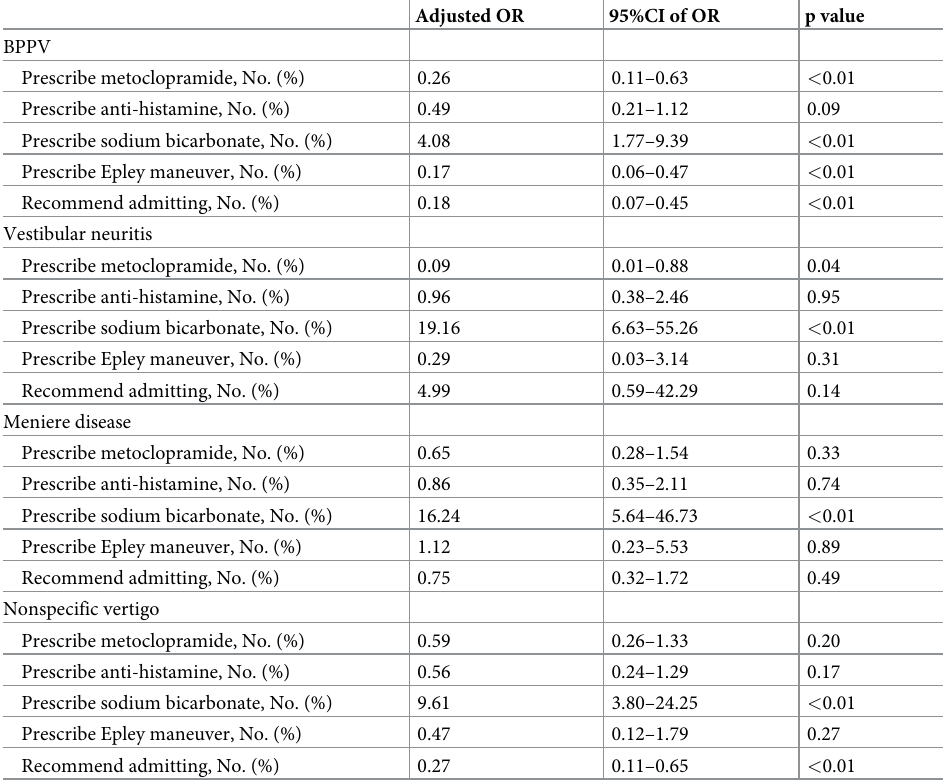
Table 5. The odds ratio and for physician’s willingness to perform each treatment and disposition among otolar- yngologists compared to non-otolaryngologists by multivariate